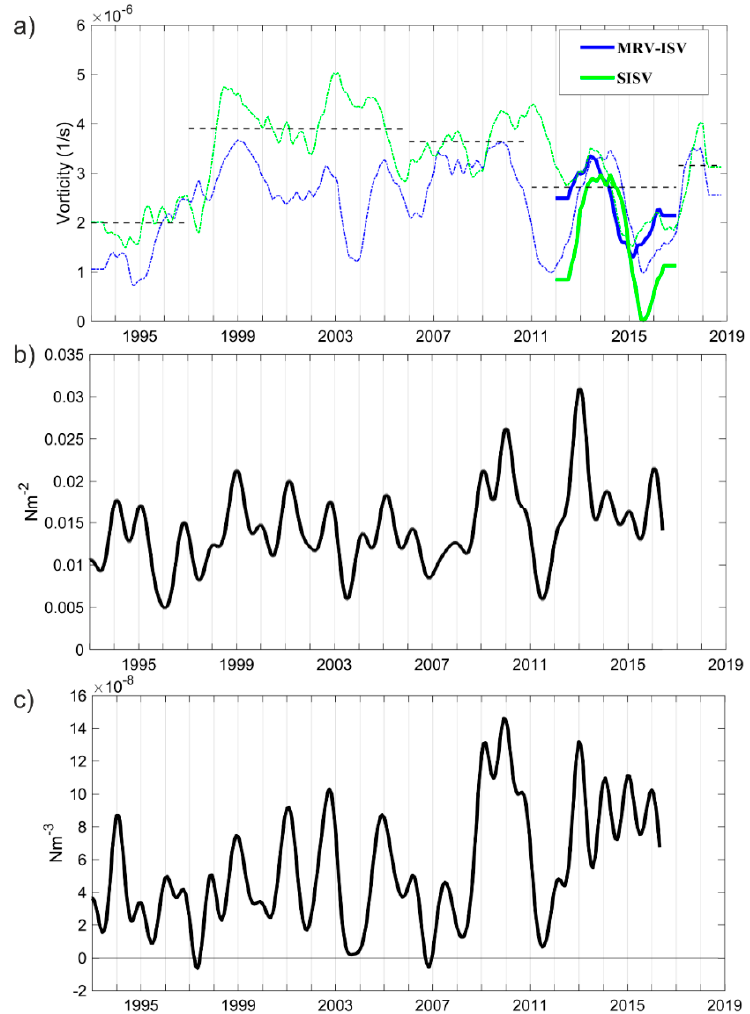
Figure 15. ( a ) Time series of the spatially averaged, low pass filtered (13 month) vorticity field over the regions of the MRV-ISV and SISV. Dashed-dotted lines refer to the vorticity field derived from the AGV. The continuous lines are related to the vorticity field derived from optimal currents from 2012 to 2016; ( b ) time series of the monthly, spatially averaged low-pass filtered (13 month) wind-stress and ( c ) wind stress vorticity in the MRV region.